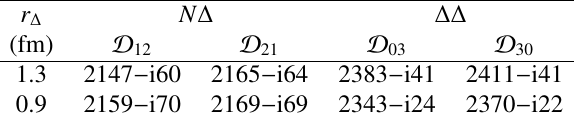
Table 2. D IS dibaryon S -matrix pole positions M − i Γ (in MeV) obtained by solving the N Δ and ΔΔ T -matrix 2 integral equation Fig. 1 are listed for π N P 33 form factors specified by radius parameter r Δ [5,